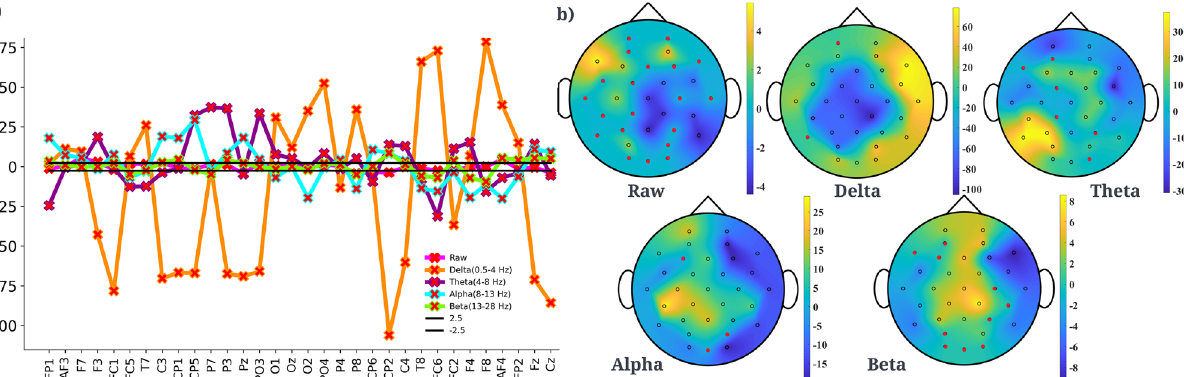
Figure 3. (a) t-value showing difference in mean amplitude (µV) between attention and distraction states in raw, delta, theta, alpha and beta brain waves data. Lines corresponding to 2.5 and − 2.5 are also shown for comprehension. (b) Topography plot of channels that show t-values of channels that had significant p-values of difference between attention and distraction in raw, delta, theta, alpha and beta brain waves after multiple correction using FDR (p-value threshold 0.0385). Channels with p-values above the threshold i.e. non- significant channels have been marked in red and corresponding t-values are plotted as zero for clarity.